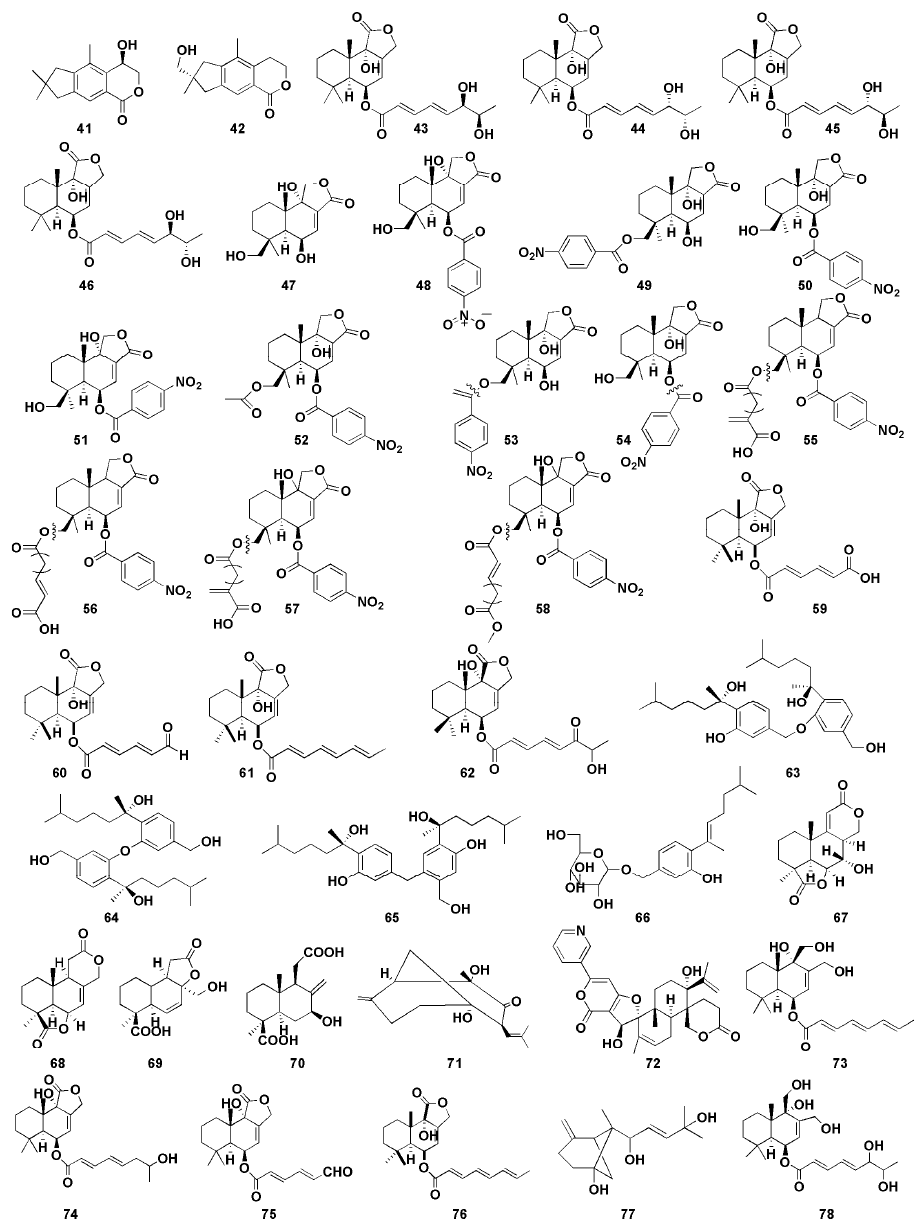
Figure 6. Chemical structures of antitumor compounds ( 41 – 78 ).